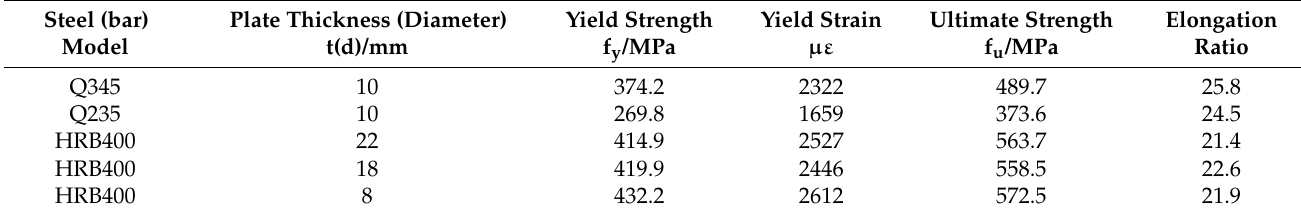
Table 1. Material properties of the steel.